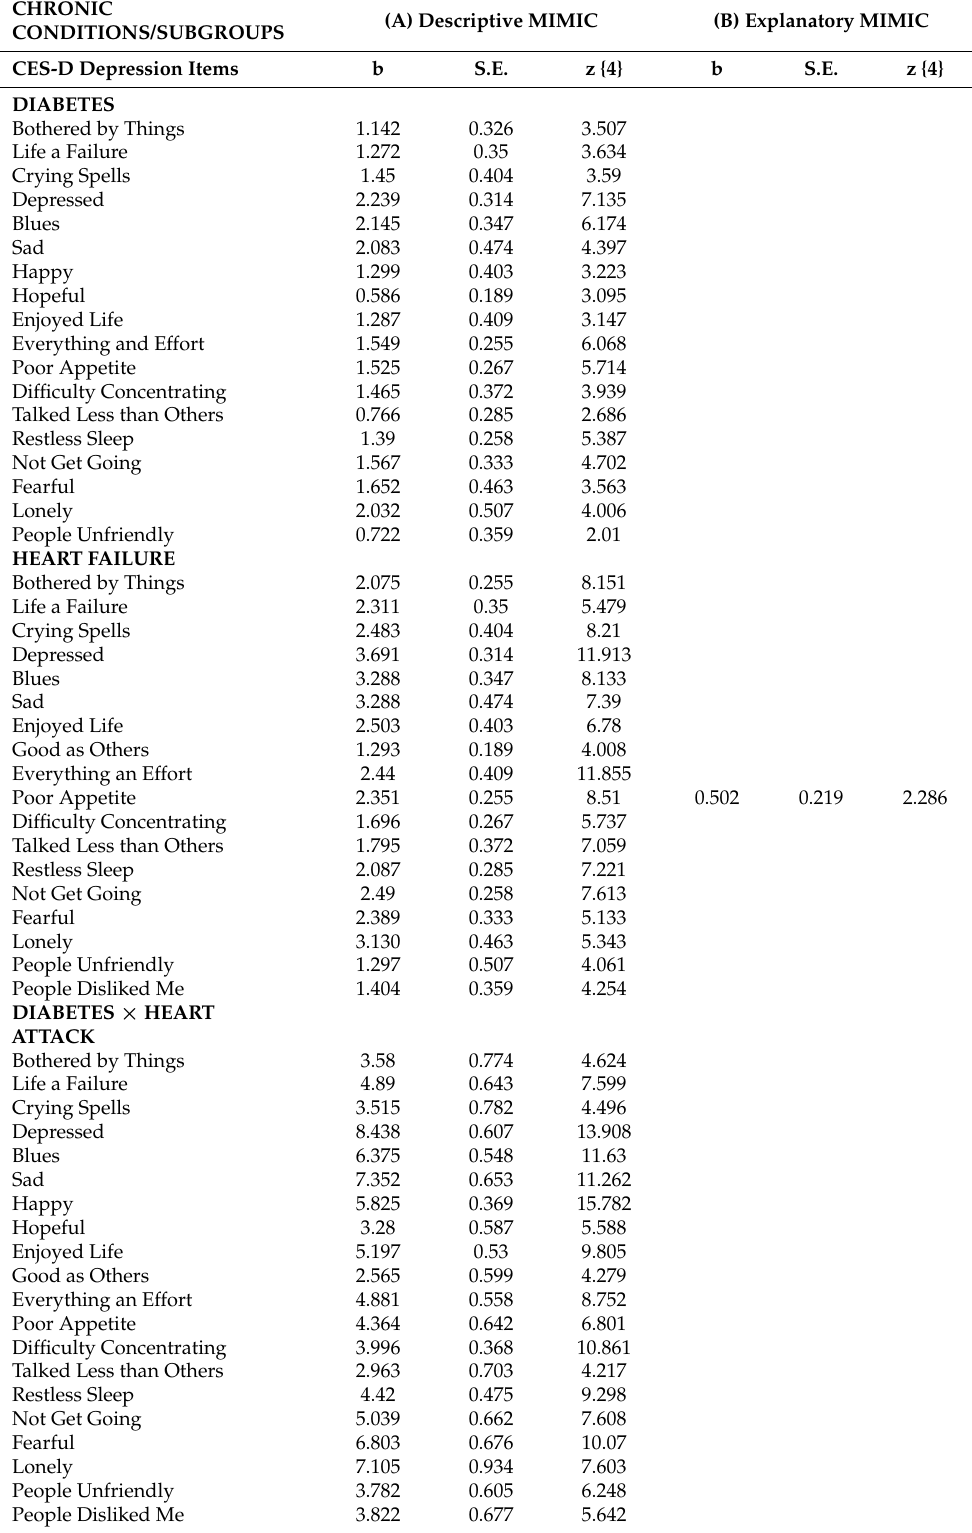
Table 1. CES-D Depression Items in Diabetes, Heart Failure, and Targeted, Synergistic Subgroups: MIMIC Models with Instrumental Variables of Four Endogenous Formative Indicators {1, 2, 3}